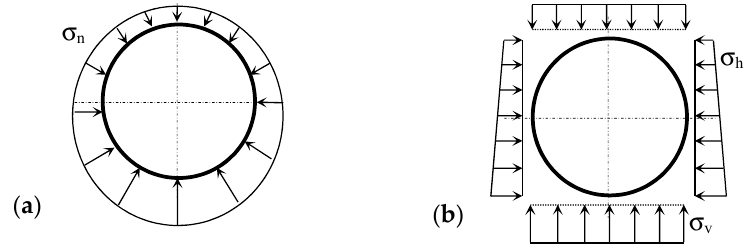
Figure 2. Load models for the lining analysis. (a) Type 0: Normal earth pressure; (b) Type 1: Vertical and horizontal earth pressure. Table 1. Stiffness of the tangential spring between the ground and lining. Value